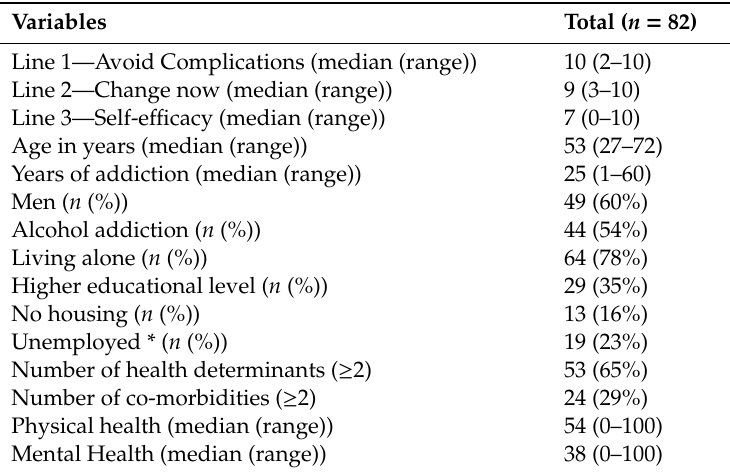
Table 1. Participant